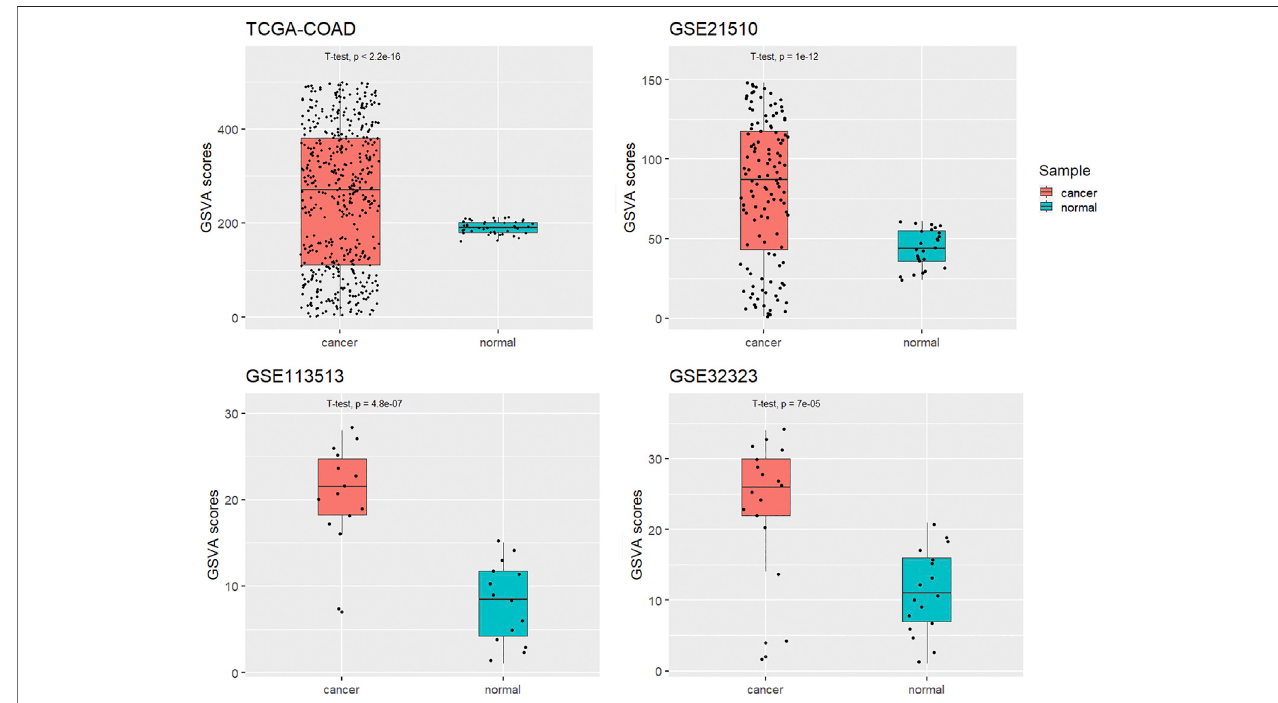
FIGURE 7 | GSVA scores of KCNQ1OT1 ceRNA network for cancer and normal samples in four different CRC